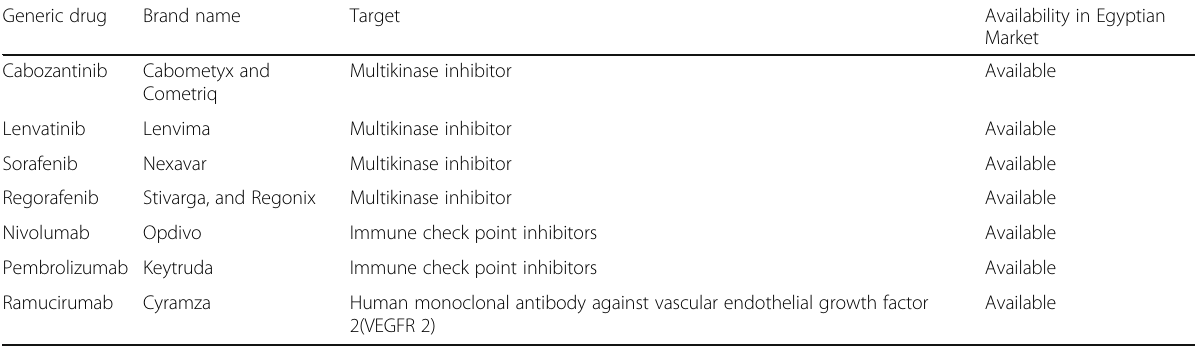
Table 2 FDA-approved targeted and immune therapies for HCC Generic